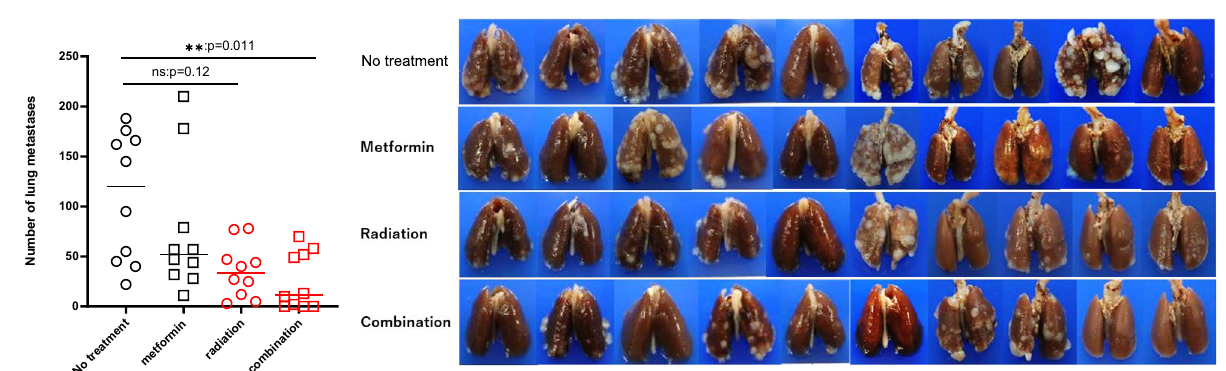
Figure 3. After sacrifice on day 28, the number of macroscopic metastatic nodules in the lungs evaluated. Data for the 2 experiments (n = 5 in each) are shown: ** p <